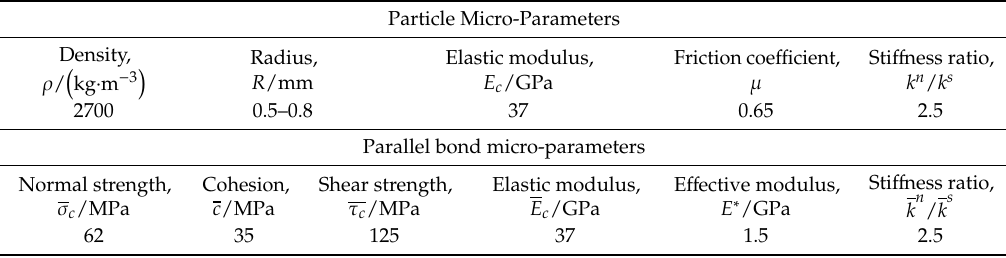
Figure 5. Comparison of axial stress–strain curves obtained from the numerical simulations and the previous experimental data [65]. Table 1. Microscopic mechanical parameters of marbles in the discrete element simulations. Particle micro-parameters Density, 𝜌/(kg ∙ m −3 )